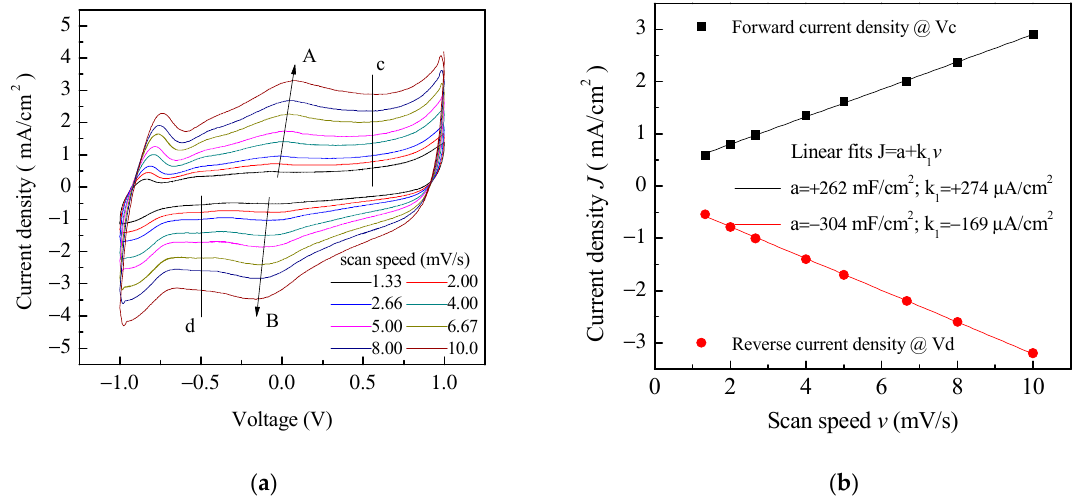
Figure 12. ( a ) Current density–voltage loop of the Au/PPy-GNP:DBSA/Nafion:LiPs/PPy-GNP:DBSA/Au cells measured at different scan speeds. The arrows mark the forward (A) and reverse (B) current density peaks whose position slightly changes with the scan speed. The vertical lines marked c and d in the flat region of the inner loop identify the voltage V c (V d ) at which the forward (reverse) current density data displayed in ( b ) are taken from; ( b ) Forward (reverse) current density J measured at the voltage V c (V d ) of Figure 11b plotted as a function of the scan speed v and linear best-fit data.